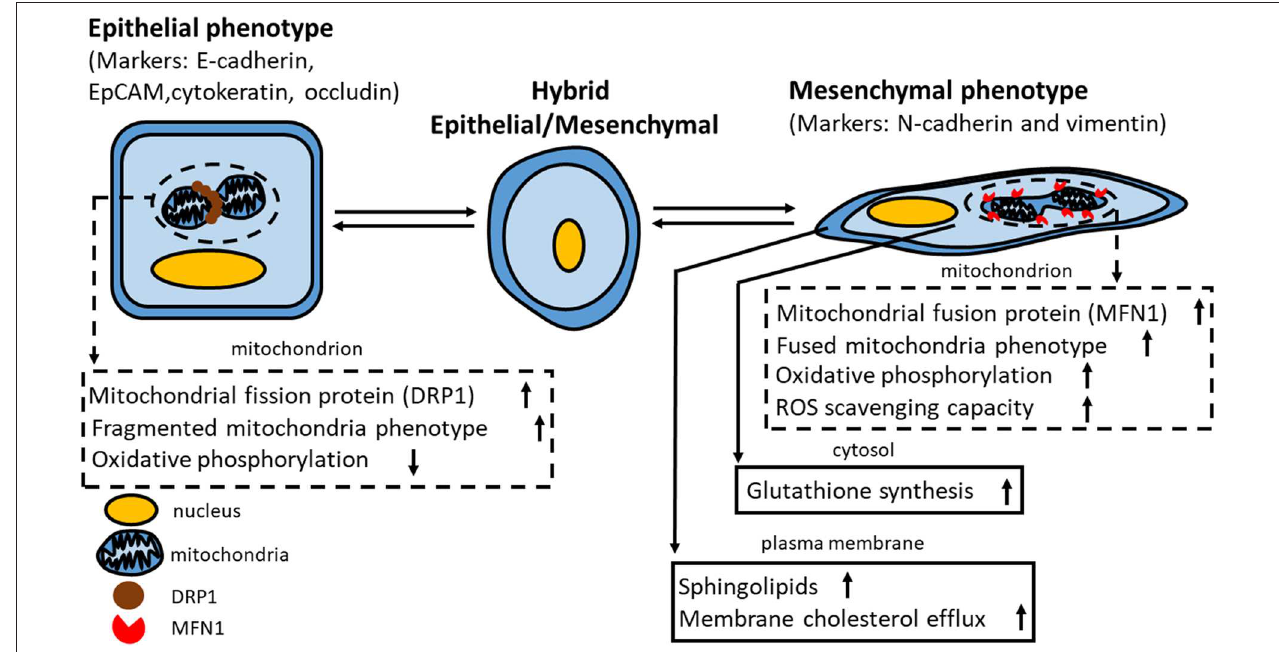
FIGURE 1 | Correlation between cancer metabolism and epithelial-mesenchymal plasticity. The schema presents the differential characteristics of metabolism in cancer cells in the epithelial, mesenchymal, and hybrid states. MFN1, mitofusin-1; ROS, reactive oxygen species; DRP1, dynamin-related protein-1. Please note that the size of mitochondria is disproportionately magnified for presenting the molecular events in epithelial/mesenchymal